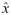
Learning to represent analog signals efficiently with spikes.A. (i) Recurrent neural network with input signals x (purple) and signal estimates x^ (green), as reconstructed or read out from the spike trains of the excitatory population (see panel B). (ii) Simplified network without separate excitatory and inhibitory populations. (F = matrix of feedforward weights, D = matrix of decoding weights, Ω = matrix of recurrent weights) A network that has learnt to represent its input signals efficiently should have connectivity Ω = −FD. (iii) Same as (ii), but unfolded to illustrate the effect of the recurrent connections. These connections act to subtract the reconstructed signal estimate from the incoming signal. As a consequence, the net input into each neuron is (a projection of) the reconstruction or coding error, x−x^. B. Linear readout of an analog signal from a population of spike trains. The spike train of each neuron is first filtered with a postsynaptic potential (left), and the filtered spike trains are then linearly combined via decoding weights D to yield a signal estimate (right, green traces). In an optimal learnt network, these signal estimates should correspond, as closely as possible, to the input signals (black traces). C. Learning of recurrent connections based on precisely balancing the EI currents into each neuron spike by spike. Shown are the neuron’s membrane voltage (black), which reflects the coding error, spikes from three inhibitory neurons (vertical lines, color-coded by connection), and the signal (purple), and signal estimate (green). (i) Ideal case with EI balance. Each inhibitory spike perfectly counter-balances the prior excitatory drive. (ii) One inhibitory synapse too weak. The excitatory drive is not perfectly cancelled, resulting in an aberrant, early spike. (iii) One inhibitory synapse too strong. The excitatory drive is over-compensated, resulting in a prolonged hyperpolarization and a delay in subsequent spiking. D. Learning of recurrent connections based on minimizing voltage fluctuations. Shown are the voltages and spikes of a pre- and a postsynaptic neuron over a longer time window (top) and the postsynaptic voltage fluctuations aligned at the timing of spikes from the presynaptic neuron (bottom, grey lines), as well as their average (bottom, black line). (i) Ideal case with EI balance. Here, the average effect of the presynaptic spike is to turn a depolarized voltage into an equivalent hyperpolarized voltage (bottom panel, black line). (ii) If the inhibitory synapse is too weak, the average membrane voltage remains depolarized. (iii) If the inhibitory synapse is too strong, the average membrane voltage becomes overly hyperpolarized. (Inset: effect of the derived recurrent plasticity rule when tested with a paired-pulse protocol).